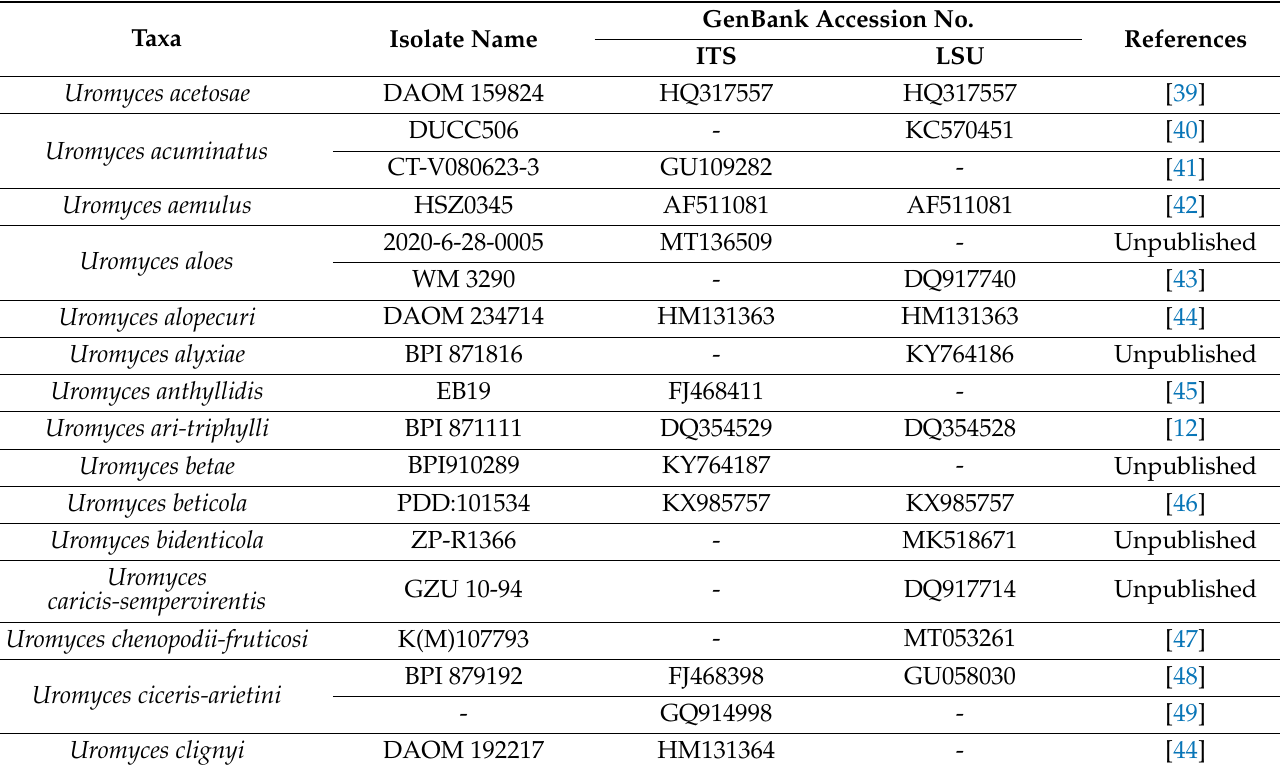
Table 2. GenBank and voucher/culture collection accession numbers of Uromyces species included in the phylogenetic